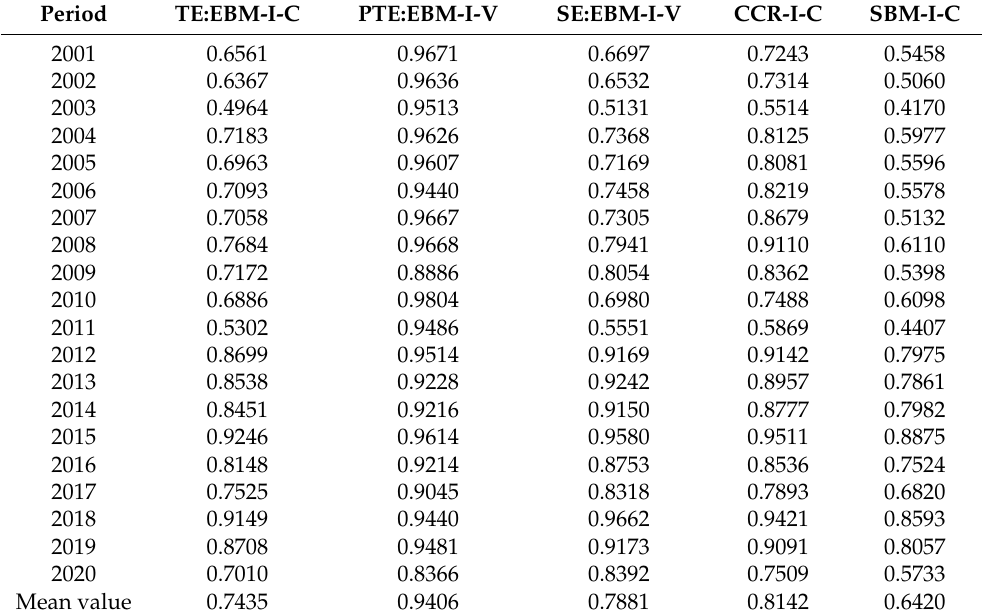
Table 2. Efficiency of tourism development in Hainan Island under different models from 2001 to